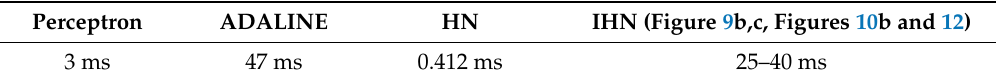
Figure 13. The scheme of an associative memory module based on IHN of N neurons for recognition (classification) of M images ( N > M ) using the trigger block and the classifier–decoder (CD) out block. Table 5. The execution time of networks algorithms in Arduino UNO [32] and the recognition time of our